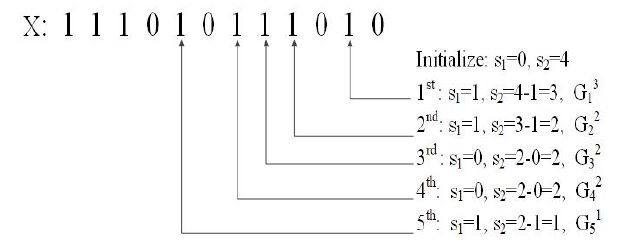
Figure 5. An example of combination